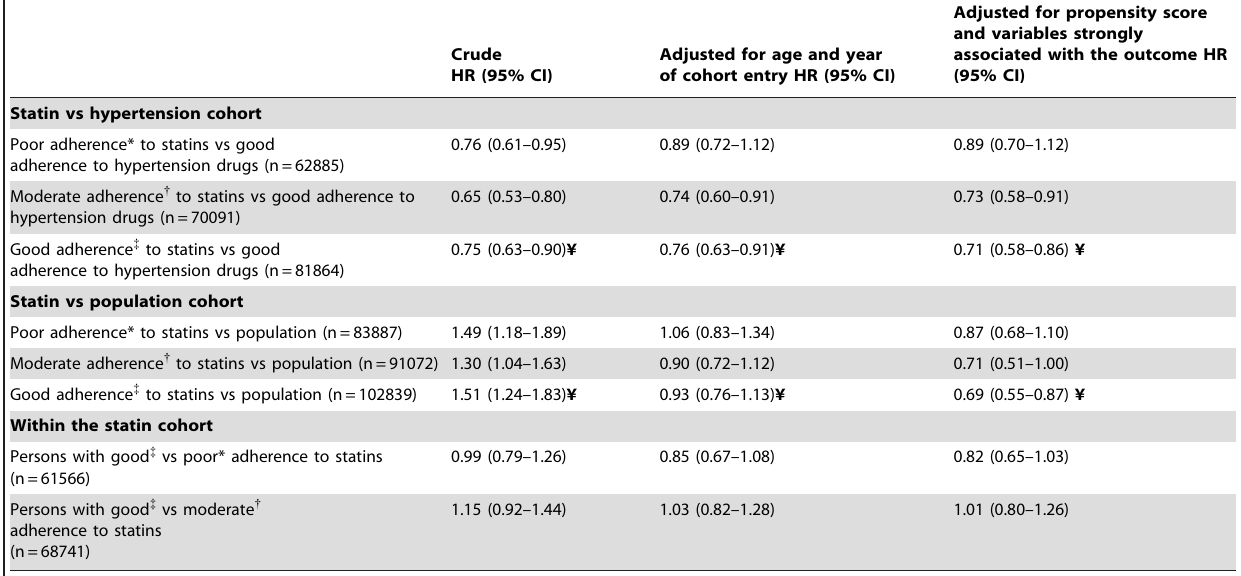
Table 4. Exposure-response relationships.